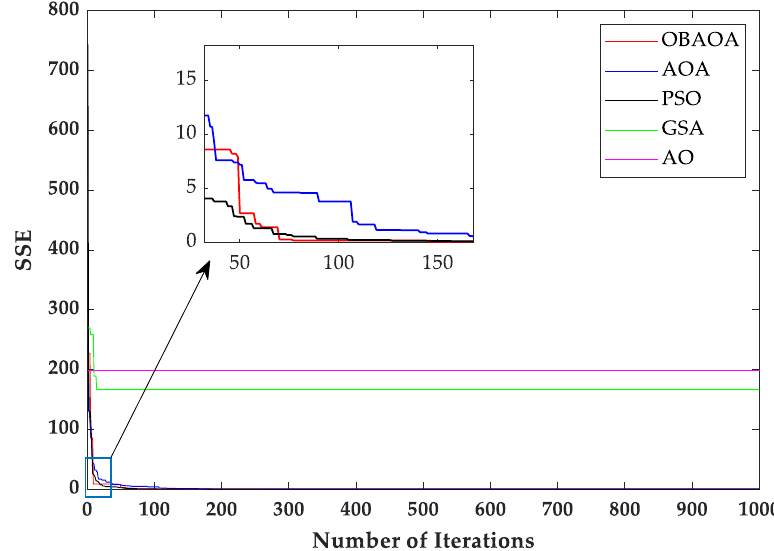
Figure 4. Convergence graph of different algorithms for Ballard Mark V fuel cell.